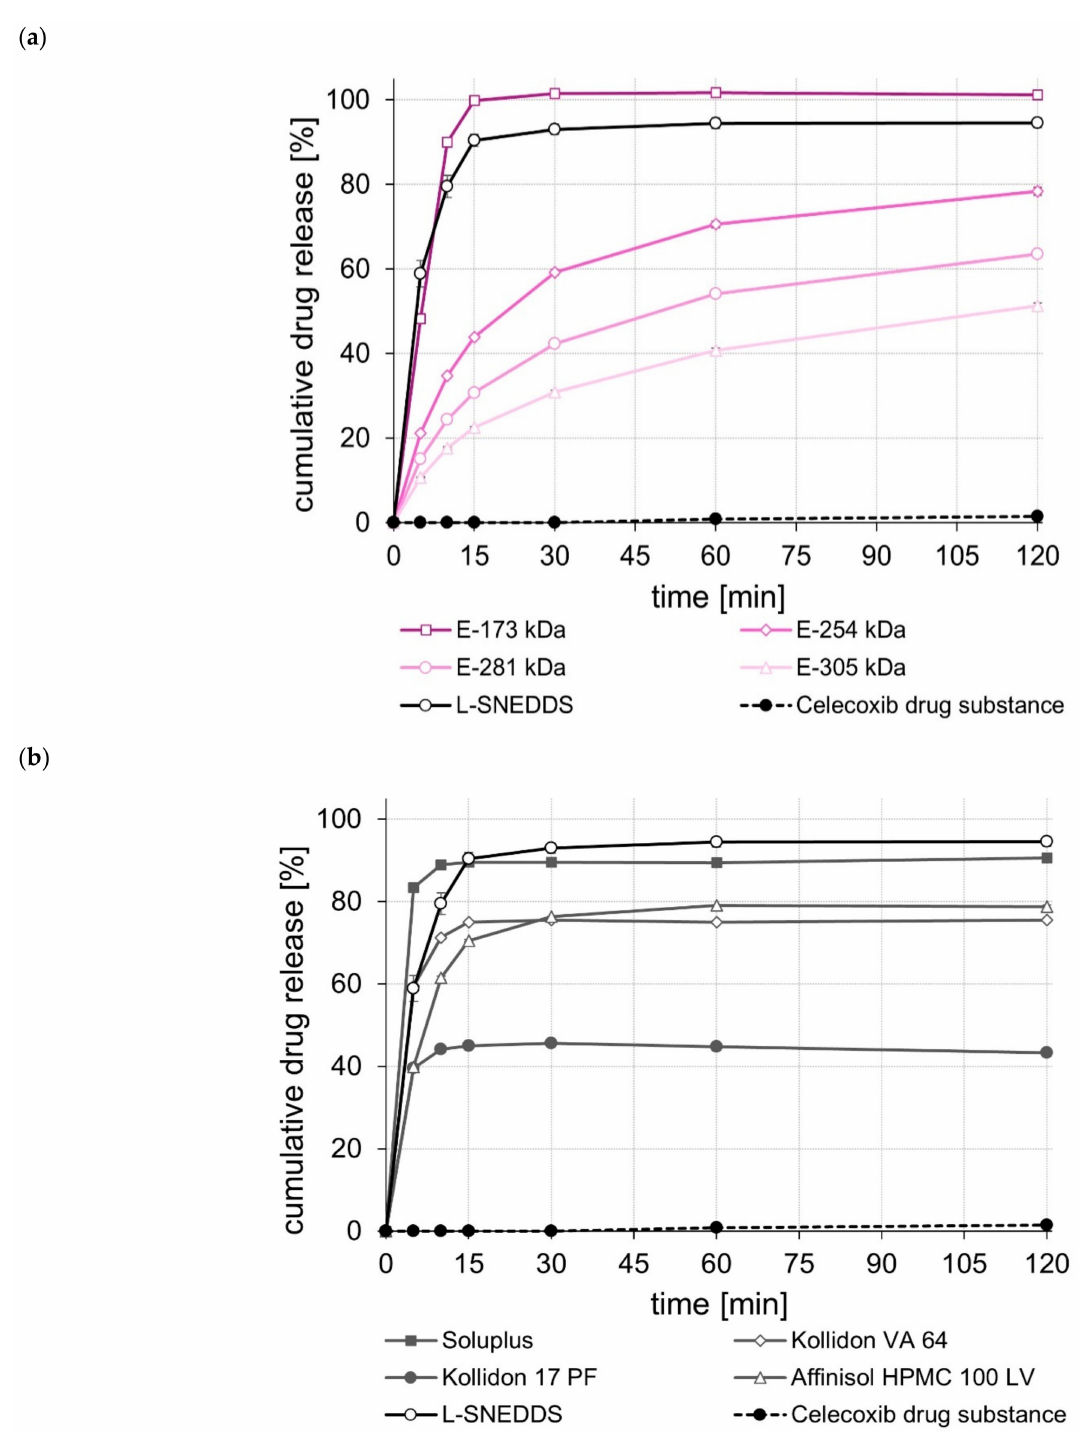
Figure 4. Dissolution profiles of the celecoxib drug substance and celecoxib L- and S-SNEDDS based on ModE ( a ), as well as the celecoxib drug substance and celecoxib L- and S-SNEDDS based on other marketed (co)polymers ( b ) after six months of storage at 30 ◦ C/65% RH in 500 mL 0.1 M HCl in USP apparatus II. Each value designates the mean ± S.D. ( n =